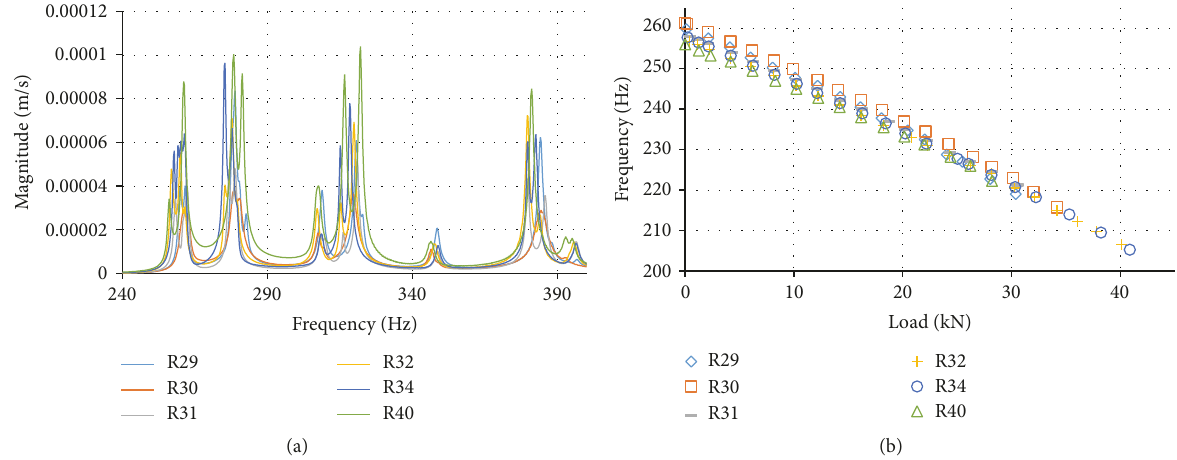
Figure 11: Natural frequency response of intact unloaded cylinders (a) and reduction of the first natural frequency with increasing axial load (b).